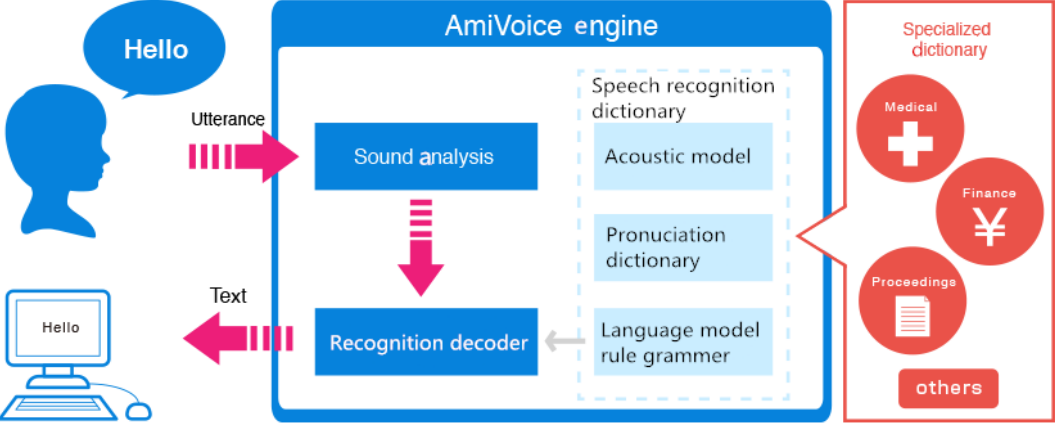
Figure 1. Block diagram of speech recognition system.